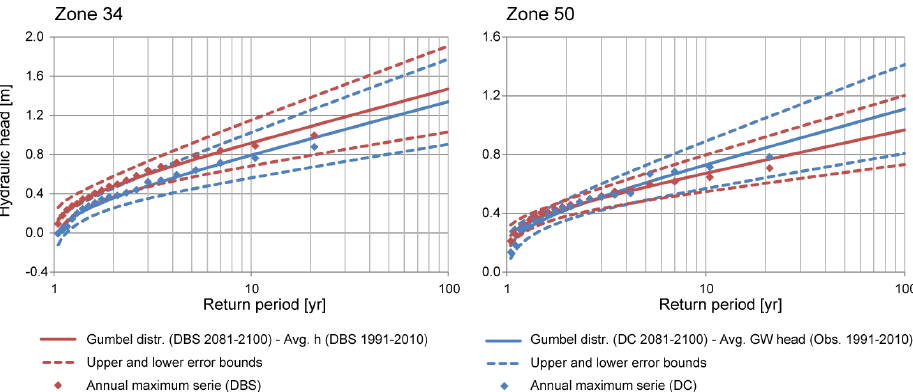
Fig. 8. Gumbel distributions for zone 34 and 50 at the motorway calculated from mean of ensembles. Distributions and associated error bounds marked with blue are based on delta change (DC) data. In the same way results using the distribution based scaling (DBS) are marked with red. Values used to parameterize the Gumbel distribution, annual maximum series of hydraulic head, are shown as red and blue dots.